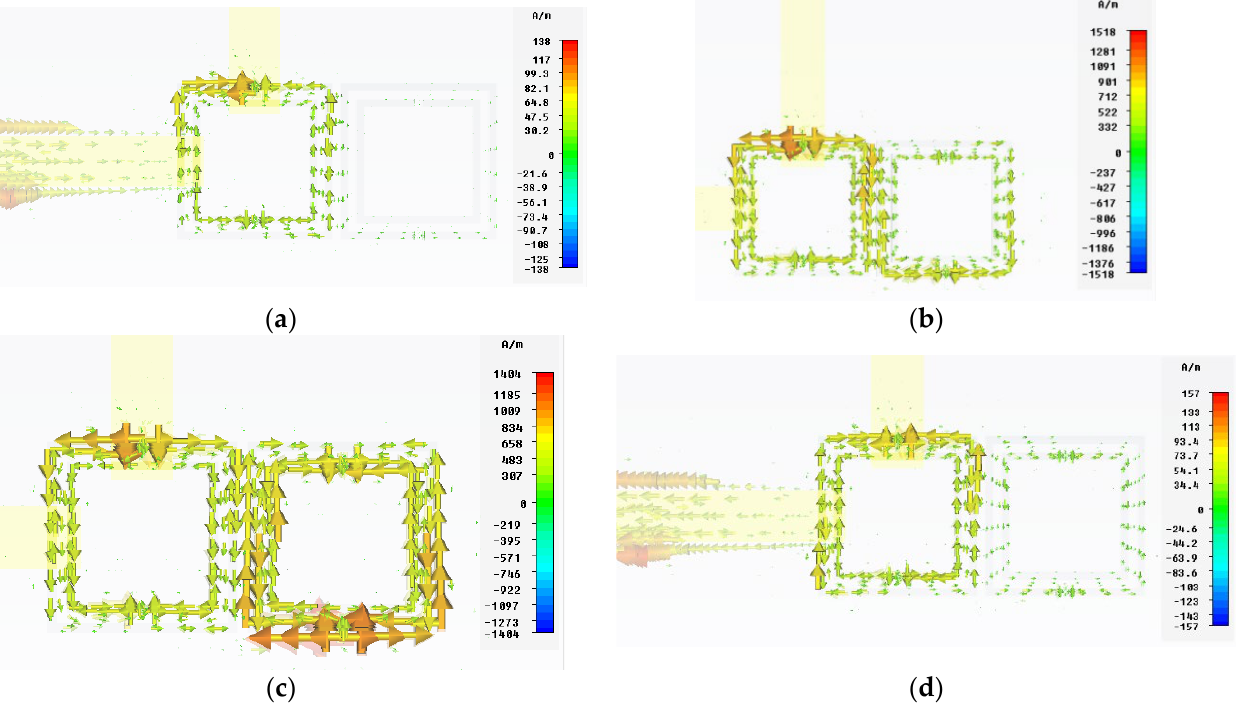
Figure 19. Vector surface current at resonant frequencies. ( a ) 5 GHz, ( b ) 5.82 GHz, ( c ) 6.32 GHz, ( d ) 7 GHz.